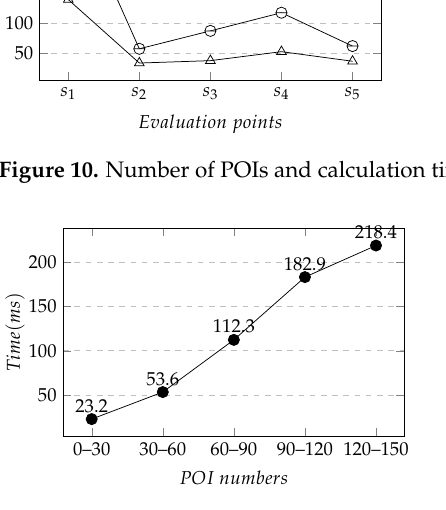
Figure 11. Number of POIs and the calculation time after dragging the